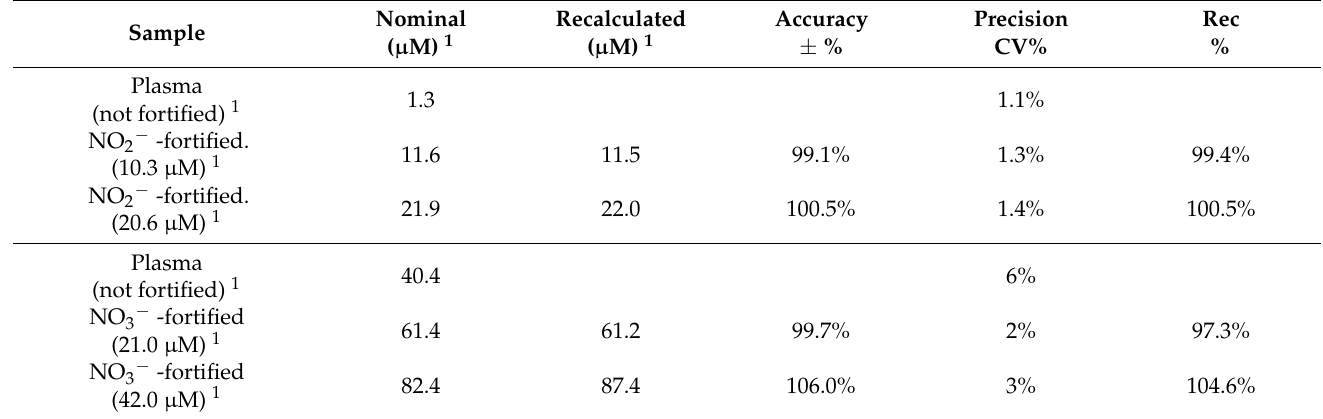
Table 3. The recovery of nitrite and nitrate in human plasma.